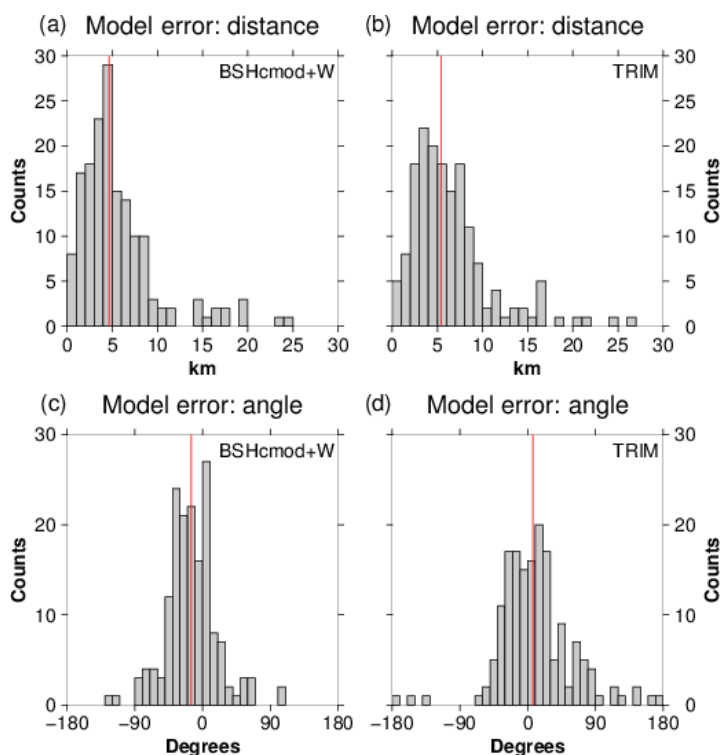
Figure 11. Distribution of model errors in 25h drifter simulations. Histograms are based on 164 simulations in total for drifter nos. 5, 6, 8 and no. 9. Referring to drift simulations based on BSHcmod + W and TRIM, respectively, panels (a, b) evaluate spatial separations shown in Fig. 10a. For the same set of 164 simulations, panels (c, d) evaluate directional errors from Fig. 10d. Red lines indicate median values (4.6 and 5.4km in a, b ; − 15 and 7 ◦ in c, d